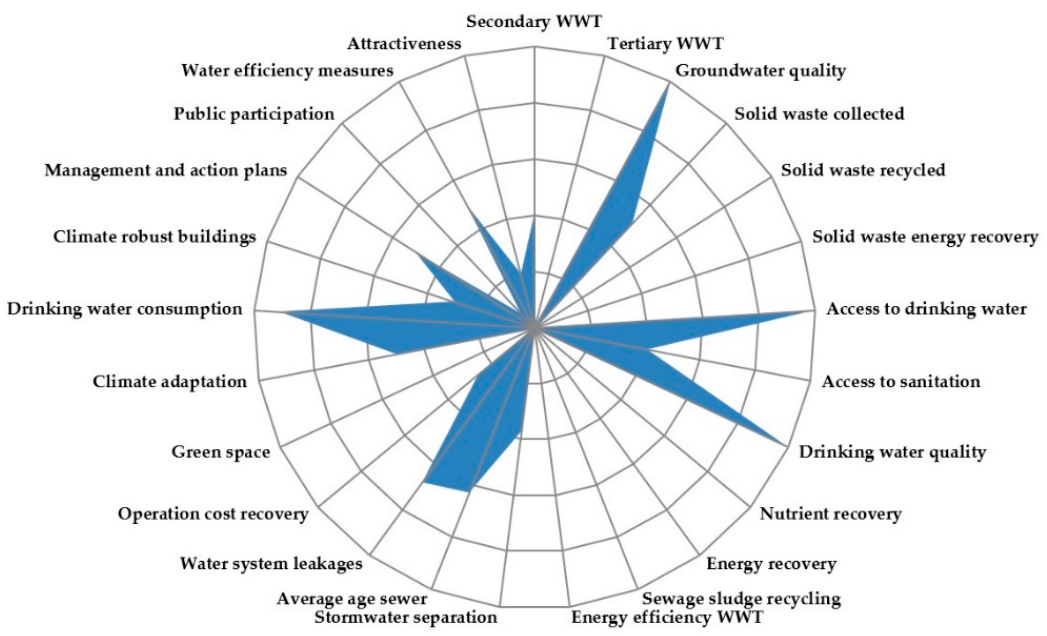
Figure 3. City Blueprint Framework results for Ulaanbaatar.